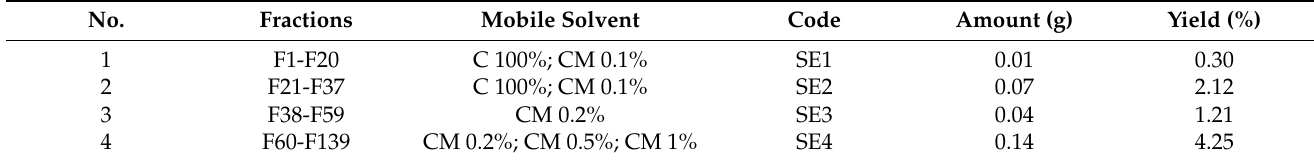
Table 2. Column chromatography process of SE extract and obtained fractions’